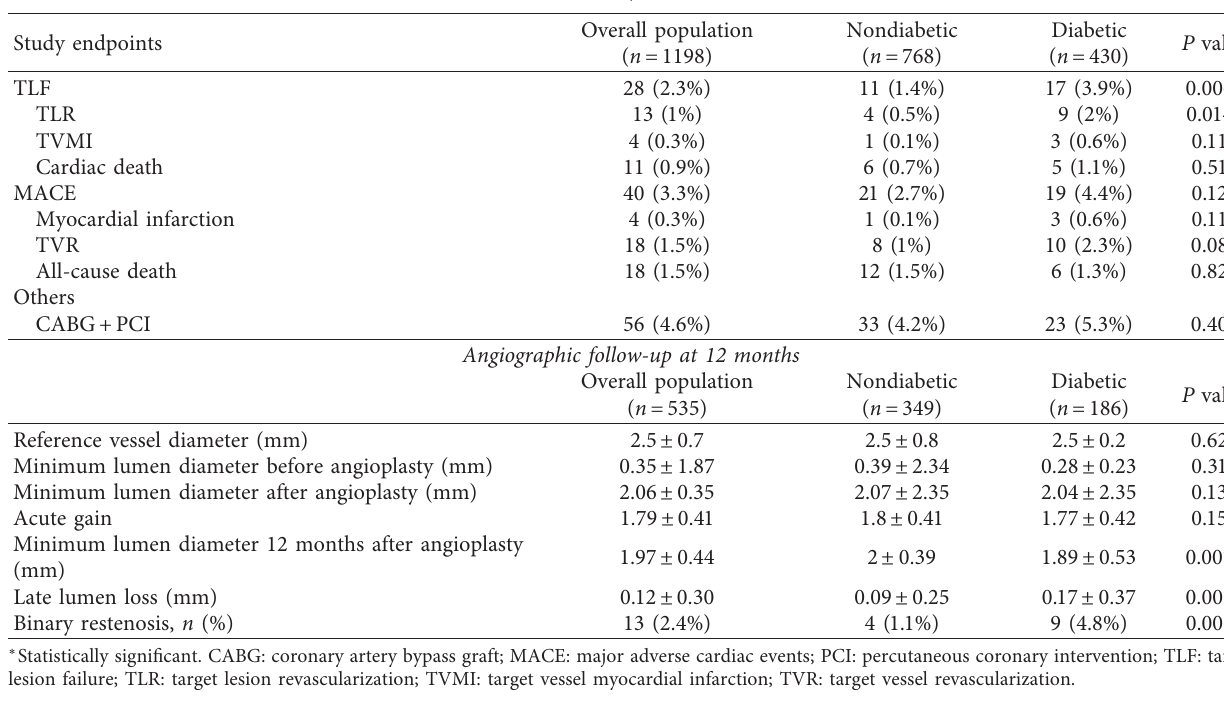
Table 4: One-year outcomes.